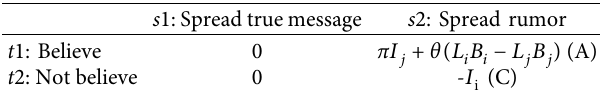
Table 1: Benefit matrix when malicious nodes disseminate messages.